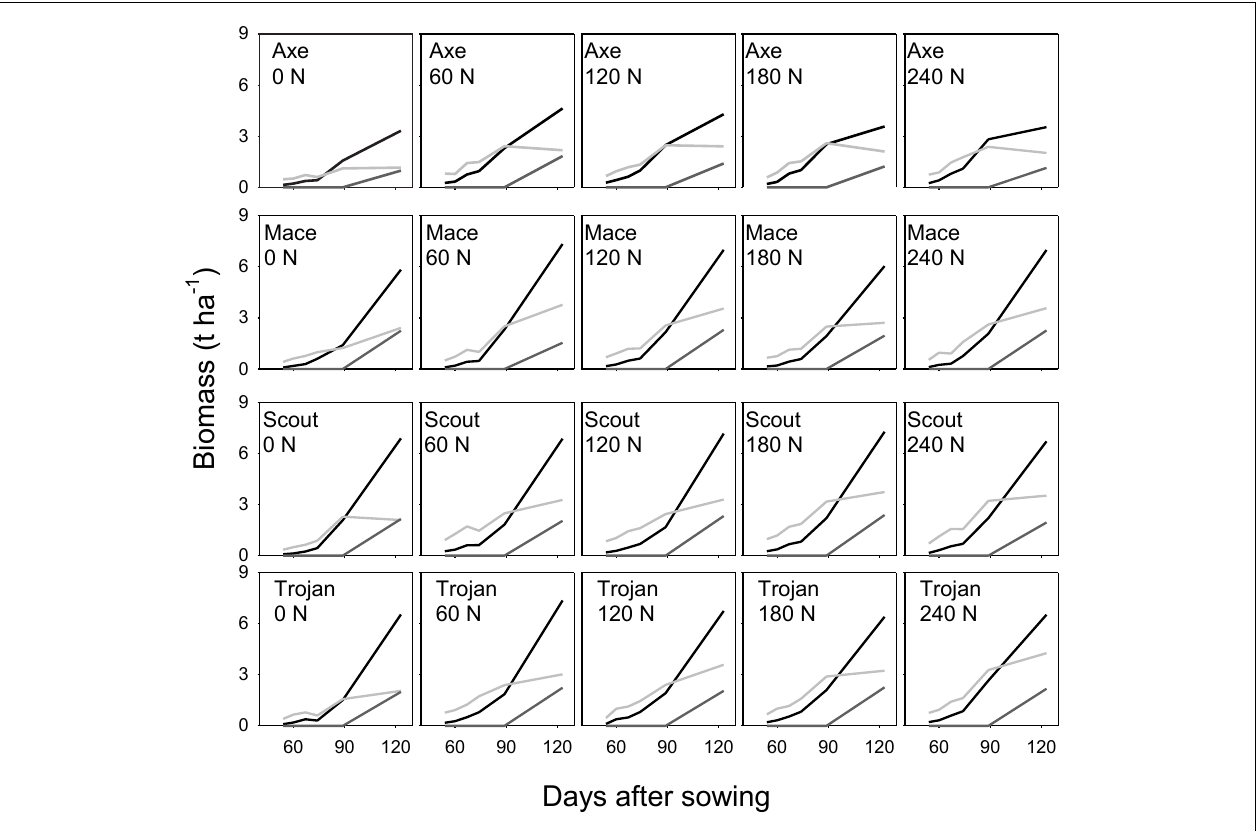
FIGURE 2 | Dynamics of dry matter in leaf (light gray), stem (black), and ear (dark gray) for wheat crops in a factorial experiment combining four varieties and five rates of nitrogen fertilizer. Data from irrigated crops at Roseworthy, 2016.